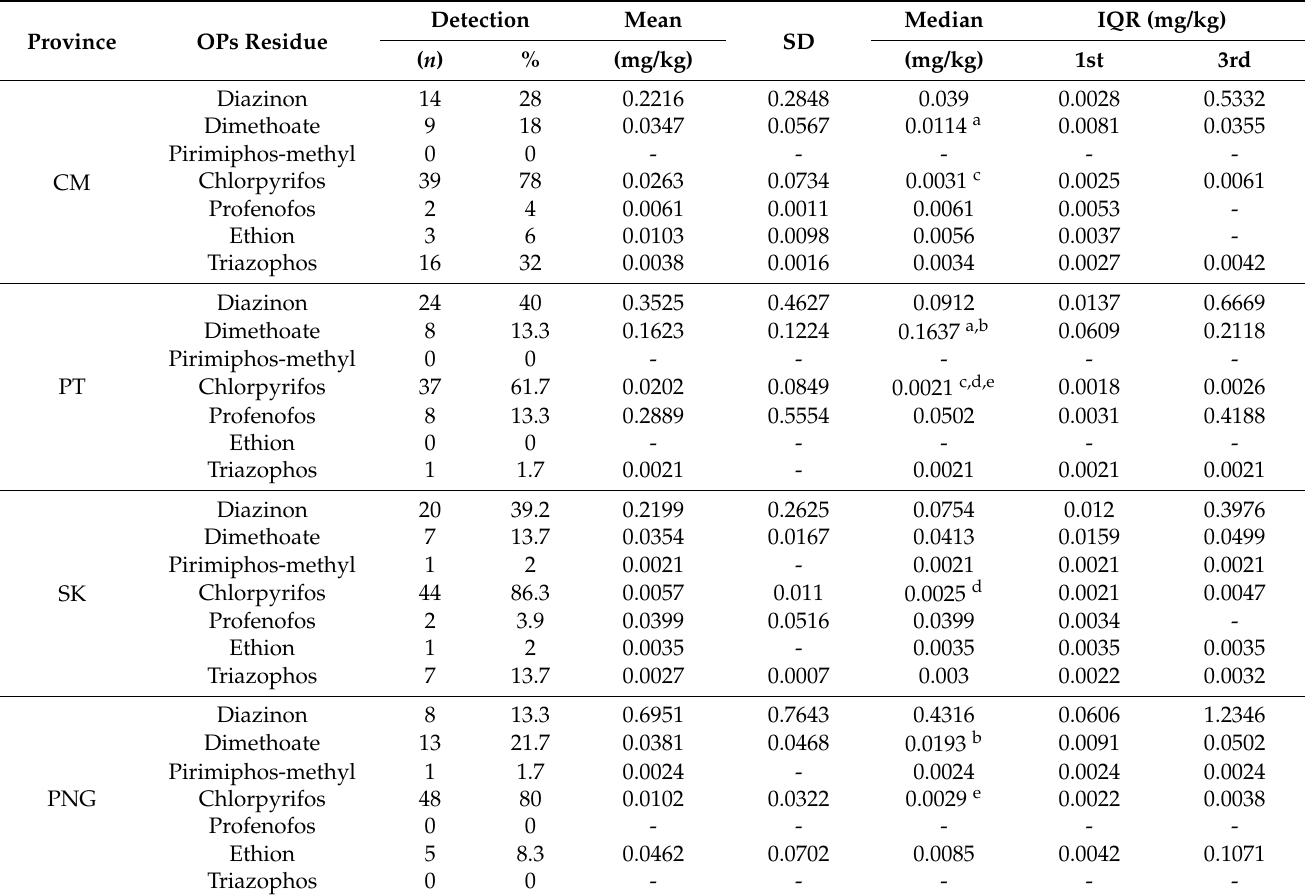
Table 3. OPs residue detection frequency and concentrations by province.